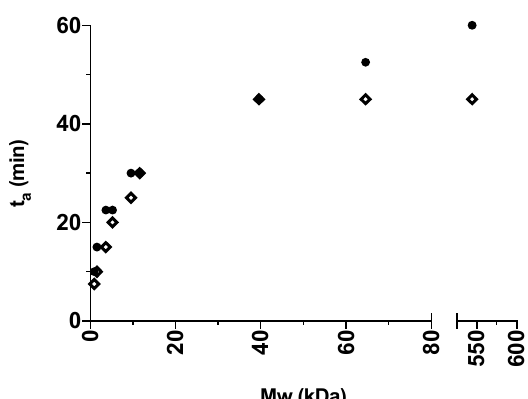
Figure 3. The t a (min) of the different IND:Dex 10:90 w/w (diamond) and CAP:Dex 10:90 w/w (circle) mixtures plotted against the average M w (kDa) of the polymer grade in the certain mixture.